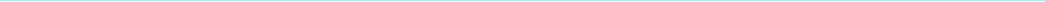
Figure 1: Schematic map of the HLA genomic region showing the positions of the HLA alleles and SNPs associated to six of the most preva- lent infectious diseases in human populations.(A): AIDS, in red; (B): Hepatitis B, in blue; (C): Hepatitis C, in grey; (L): Leprosy, in orange; (M): Malaria, in pink; (T): Tuberculosis, in green. Protective HLA alleles are in bold, susceptibility HLA alleles are in italics.The genomic regions shown at the right as putatively involved in disease associations are only based on SNP information, except for malaria (dashed line).The ge- nomic positions (GRCh38) of the HLA genes and SNPs have been determined by using the e!Ensembl [148] and NCBI dbSNP [149] databas- es accessed on 9 December 2019 at https://www.ensembl.org/index.html and https://www.ncbi.nlm.nih.gov/snp/,